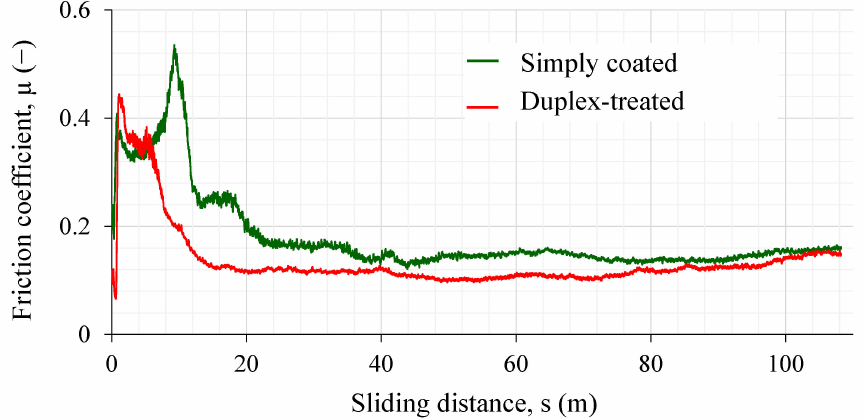
Figure 7. Friction coefficient curves obtained for the simply coated and duplex-treated samples during the ball-on-disk wear